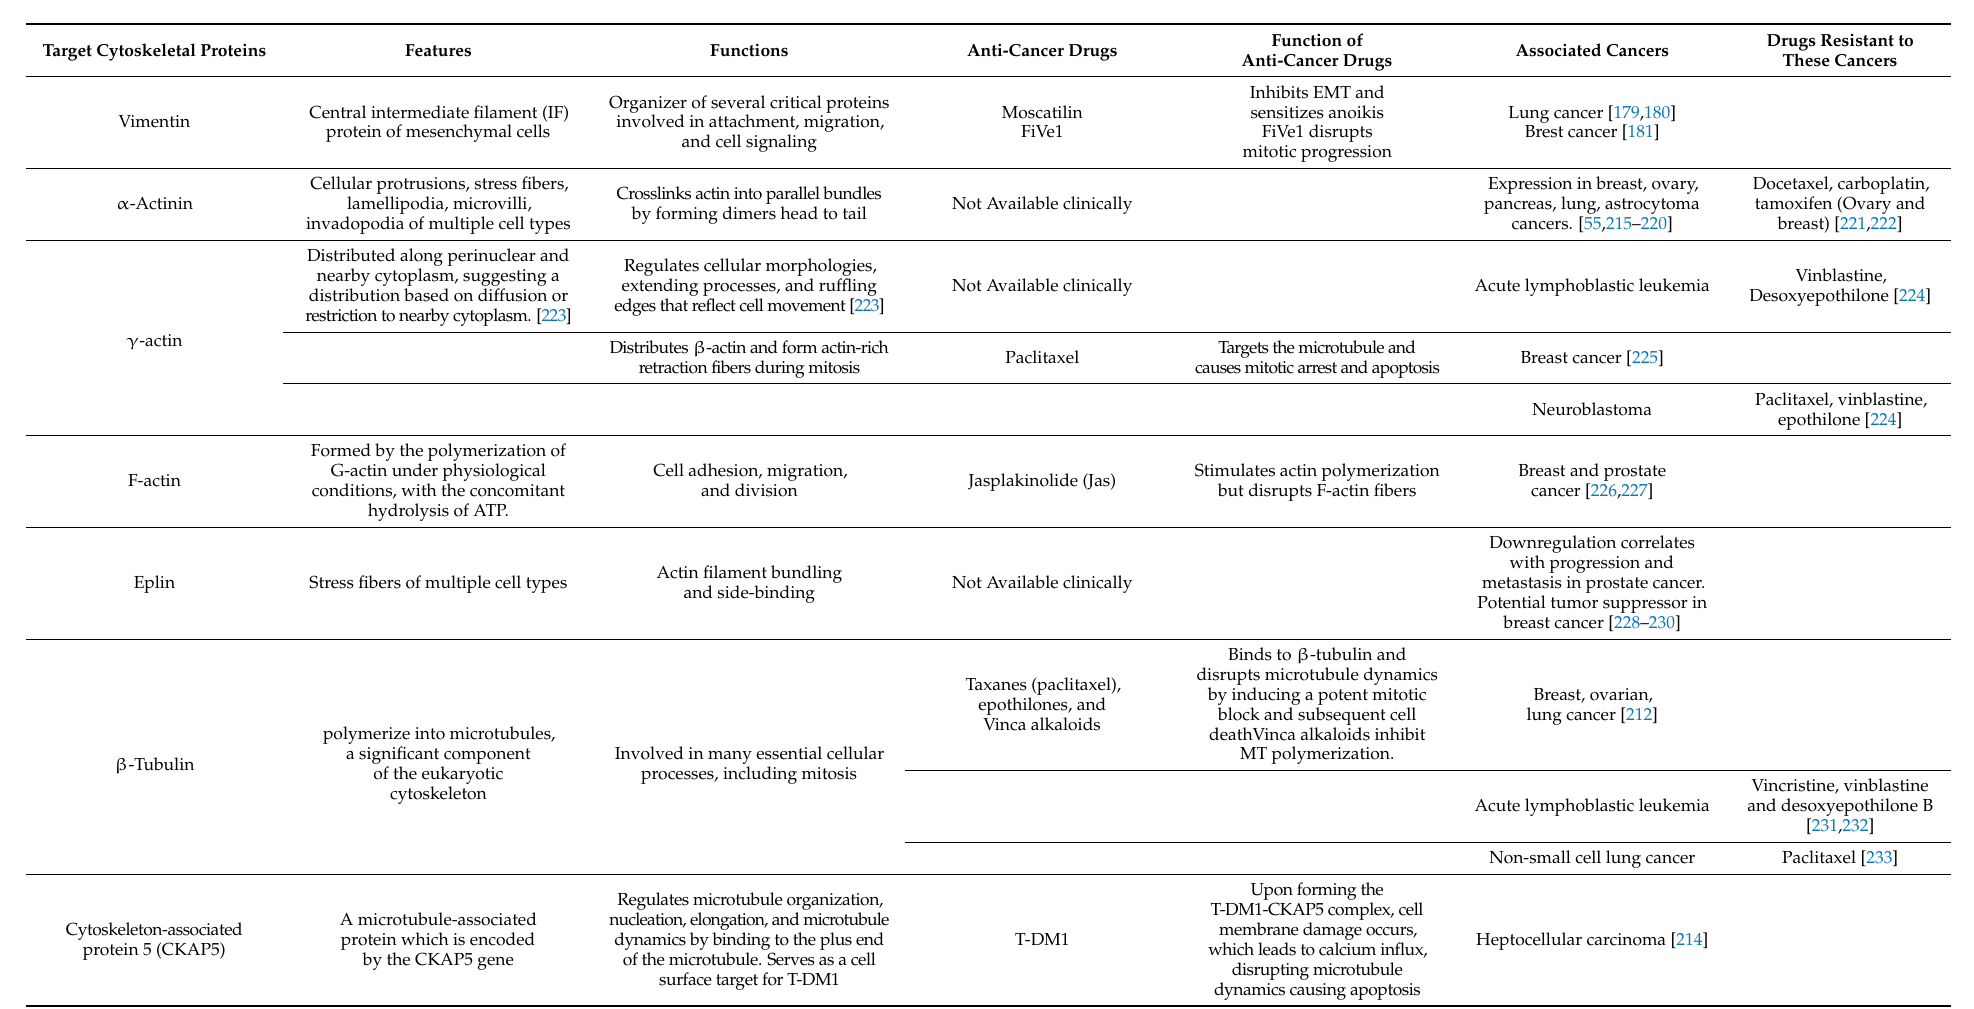
Table 3. Anti-cancer drugs which target the cytoskeletal proteins to alter or inhibit EMT in cancer therapy. The associated cancers and drugs which are resistant to these cancers are also laid